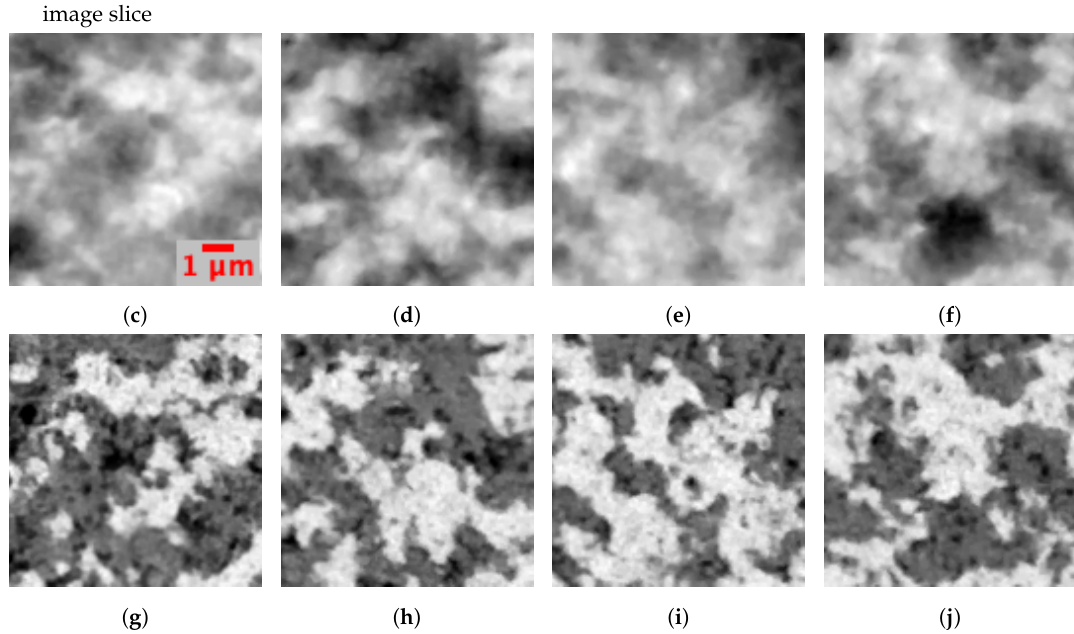
Figure 11. Training slices and synthesized multimodal slices with resolution of 62.4 µ m/voxel: ( c – f ) synthetic TXM image patches and ( g – j ) synthetic SEM image patches corresponding to the generated TXM images.